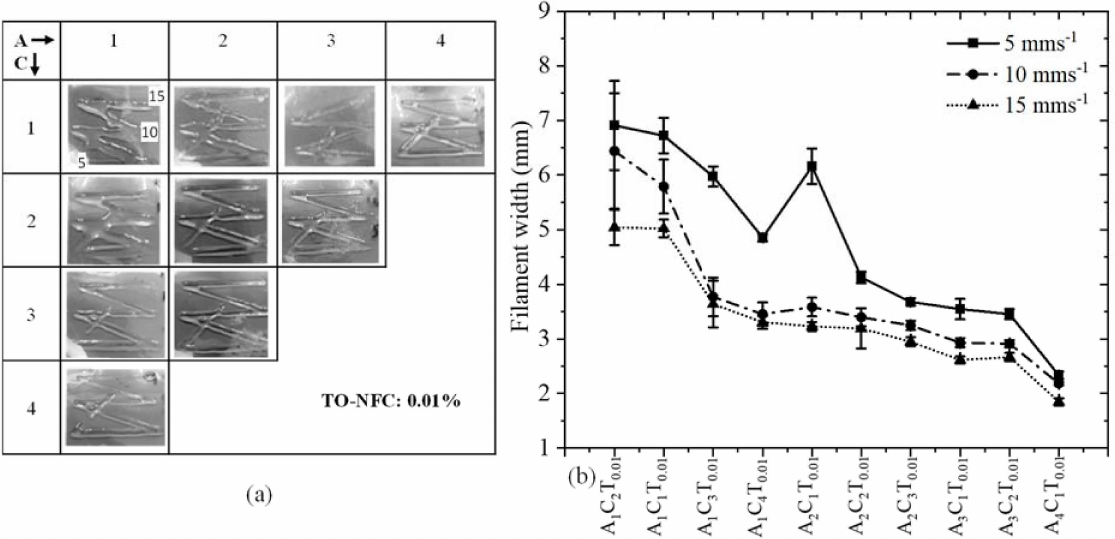
Figure 13. ( a ) Fabricated filaments with 1%, 2%, 3%, and 4% alginate; 1%, 2%, 3%, and 4% CMC; and 0.01% TO-NFC. ( b ) Filament widths of all those compositions.